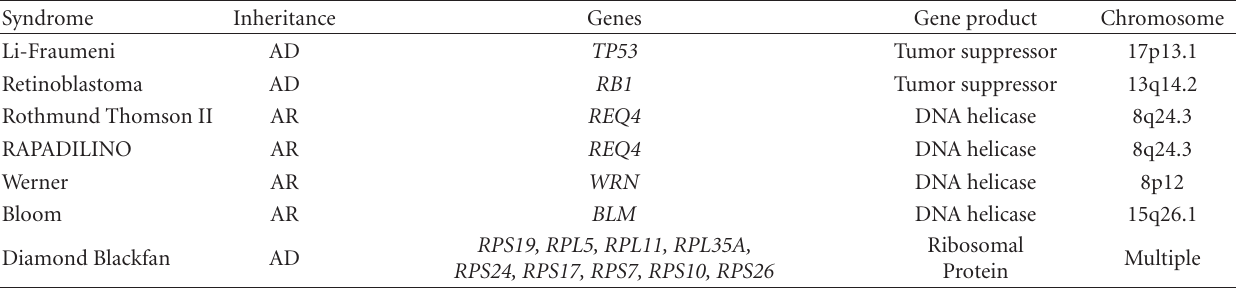
Table 1: Osteosarcoma predisposition syndromes and their associated genes.